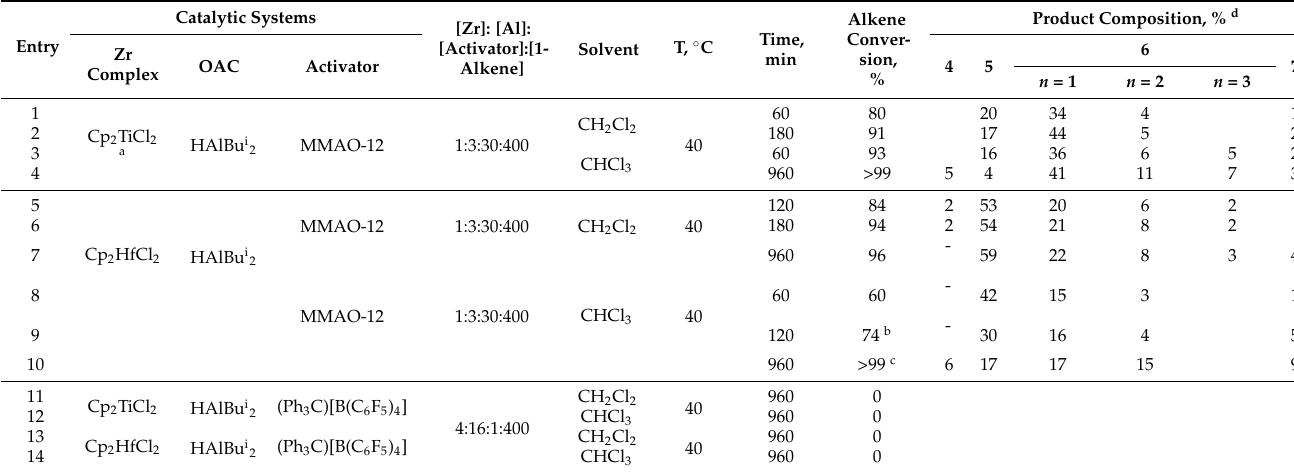
Table 2. Catalytic activity and chemoselectivity of systems Cp 2 MCl 2 -HAlBu i 2 -activator (M = Ti, Hf) in the reaction with 1-hexene.